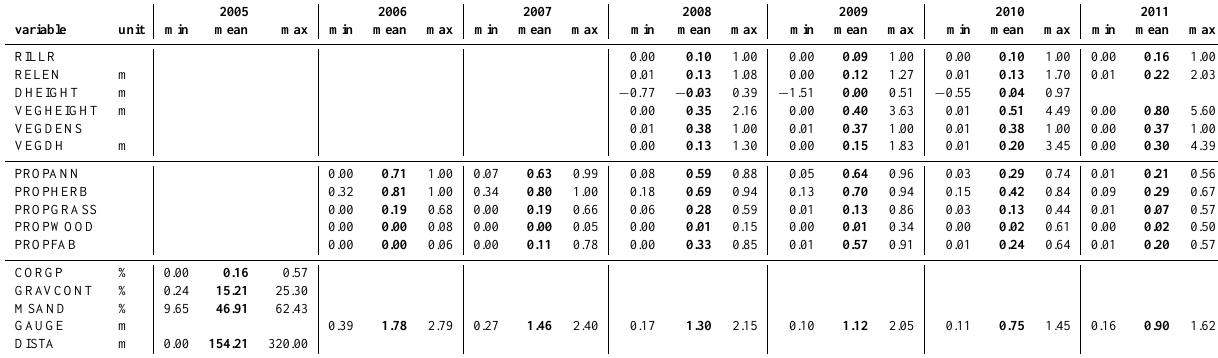
Table 2. Summary statistics of the variables used in this study (see Table 1 for variable explanations). DHEIGHT, indicating a change between subsequent years, is given always at the start year. The soil-related variables CORGP, GRAVCONT, and MSAND were only measured once in 2005. DISTA does not change with time and is presented for the time when the catchment’s establishment was completed. The variable COVTOT is shown in Table 3 together with other vegetation properties.